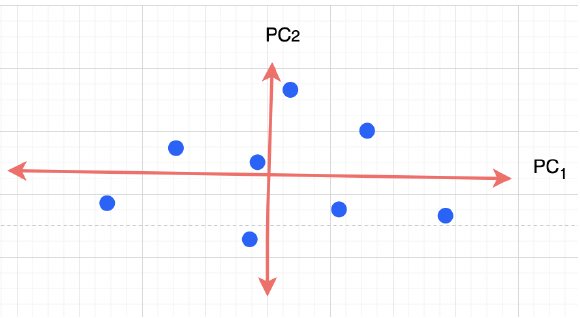
Figure 5. Projection of data points in the two newly constructed